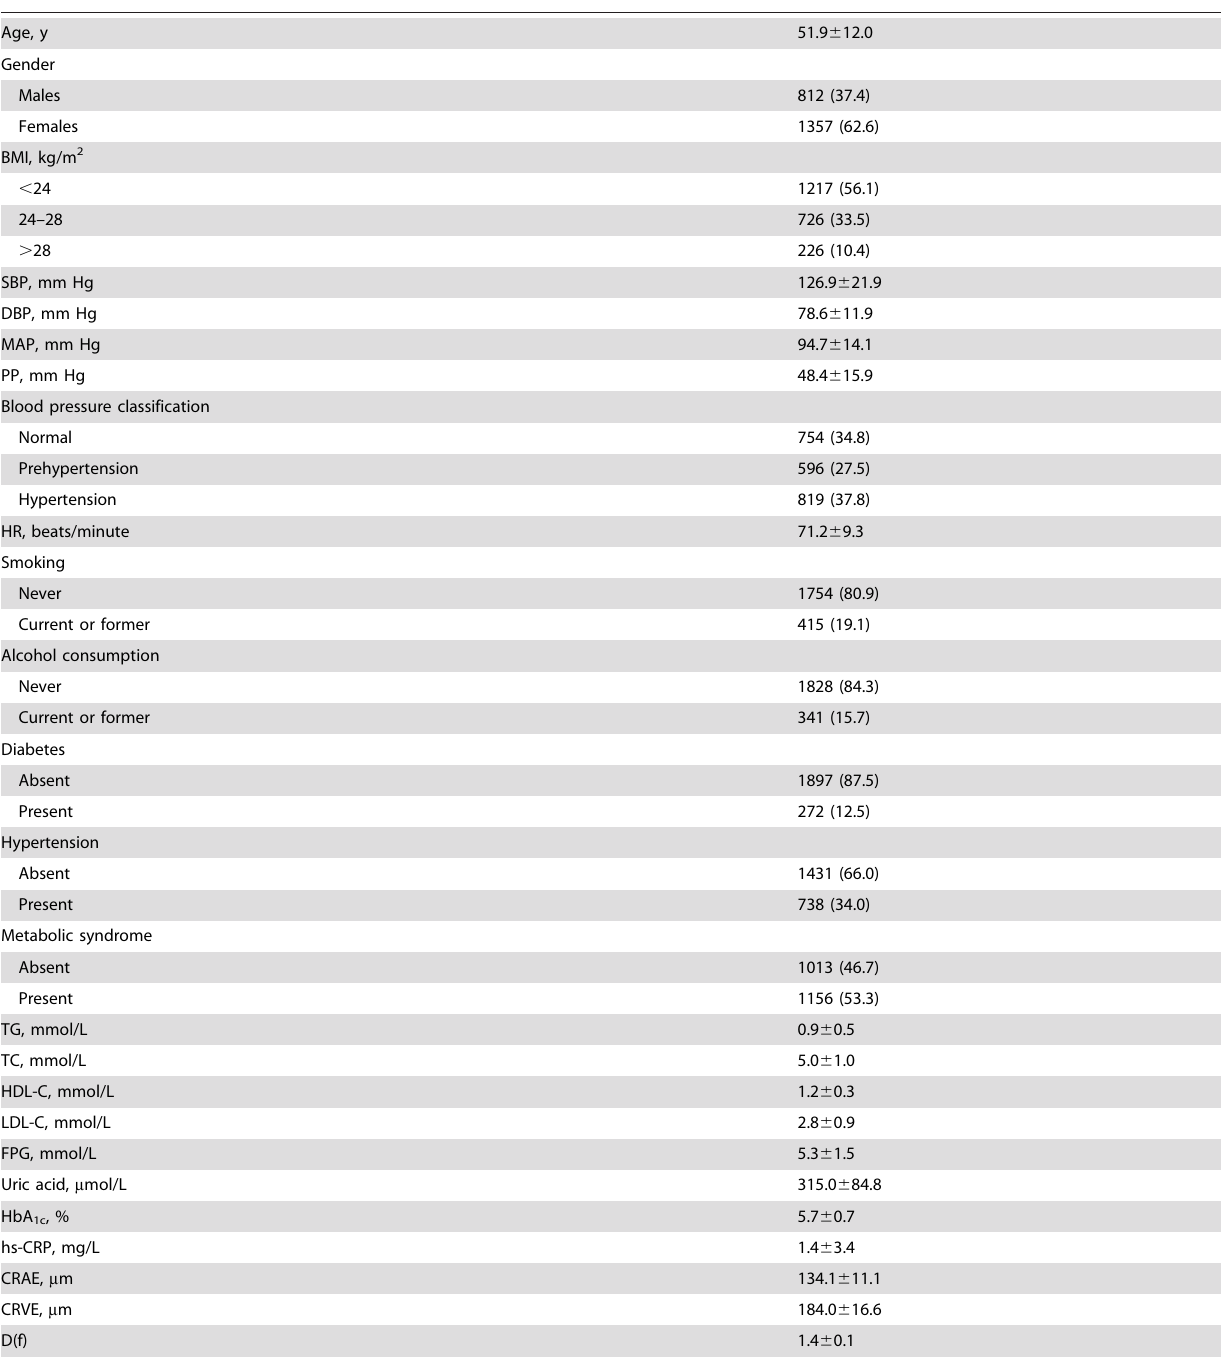
Table 2. Characteristics of study subjects